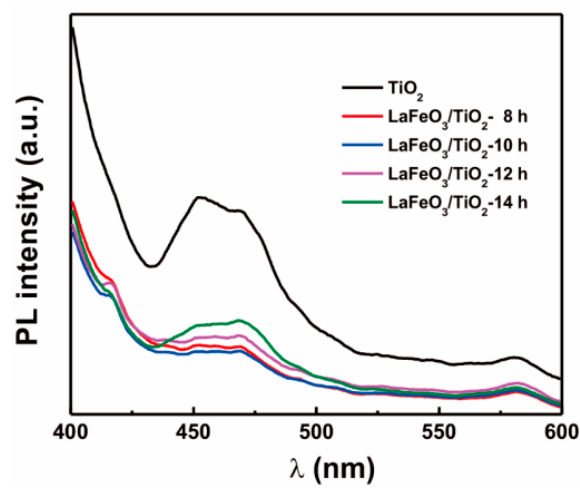
Figure 5. PL spectra of TiO 2 nanotube arrays and LaFeO 3 /TiO 2 nanotube arrays.